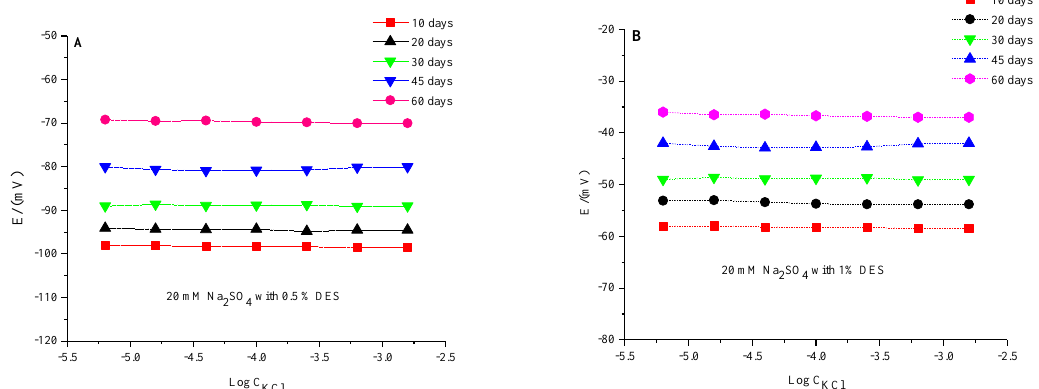
Figure 6. Potential dependency profile of the DES-based fabricated reference microelectrode against varying concentrations of Cl − ions in a 20 mM Na 2 SO 4 supporting electrolyte measured for 60 days.